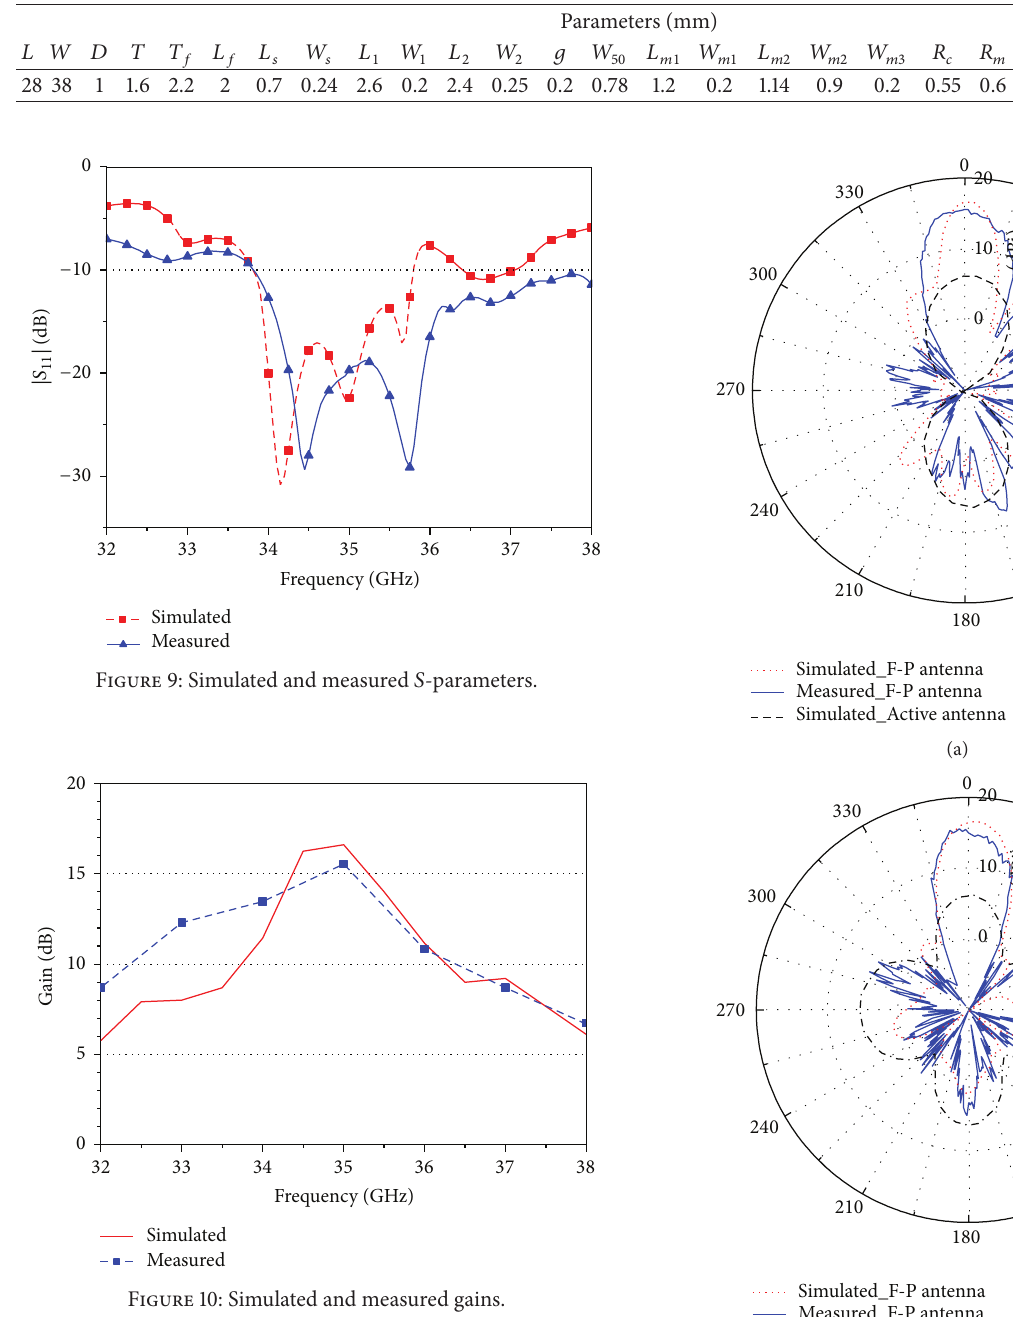
of the primary feeding antenna are plotted, too. The primary antenna has a bidirectional radiation pattern and the gain in the broadside is only 6.1 dBi. When the PRS is covered above the primary antenna, the sidelobe at 𝜃 = 90 ∘ and the back radiation of the primary feeding antenna in the H-plane are suppressed and the gain of the F-P antenna is increased by 10.5 dB. The measured sidelobe level is − 9.5 dB and the front- to-black ratio is 11.5 dB.